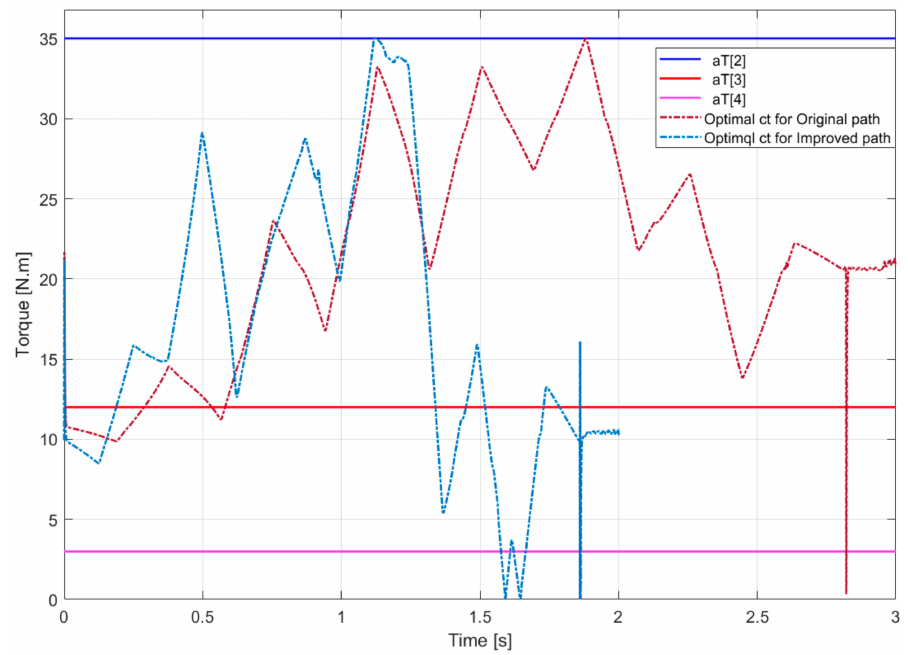
Figure 21. Optimal cycle time values for the original and improved